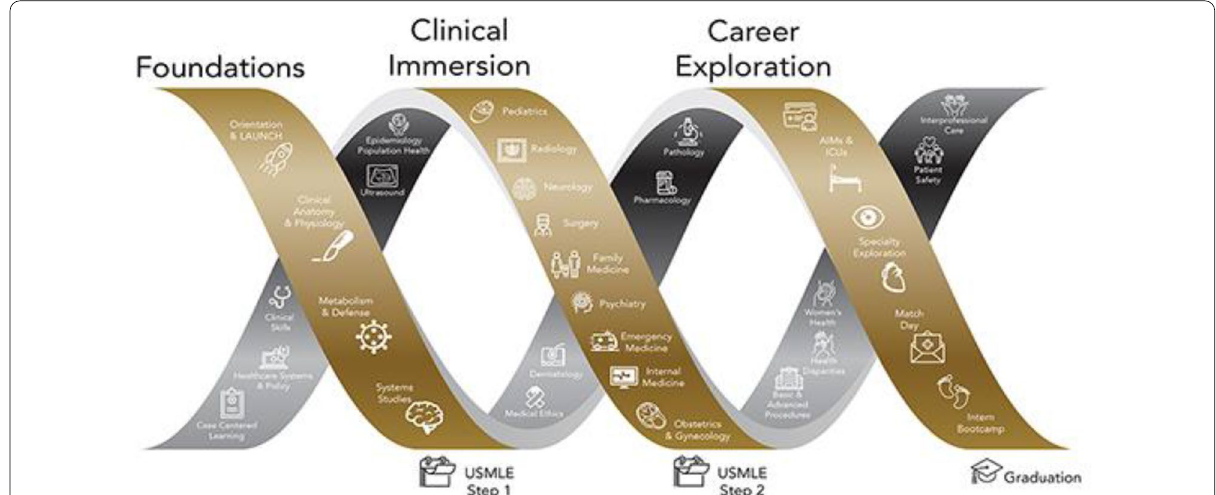
Fig. 2 The Wake Ready! Curriculum is divided into three phases to better prepare medical students for the next step in their training. Phases are divided into requisite focuses as Foundations, Clinical Immersion and Career